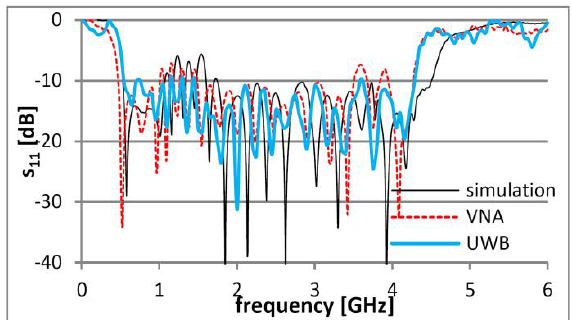
Figure 9. The simulated and measured values of parameter s 11 for the manufactured antenna with the CPWG feeding.